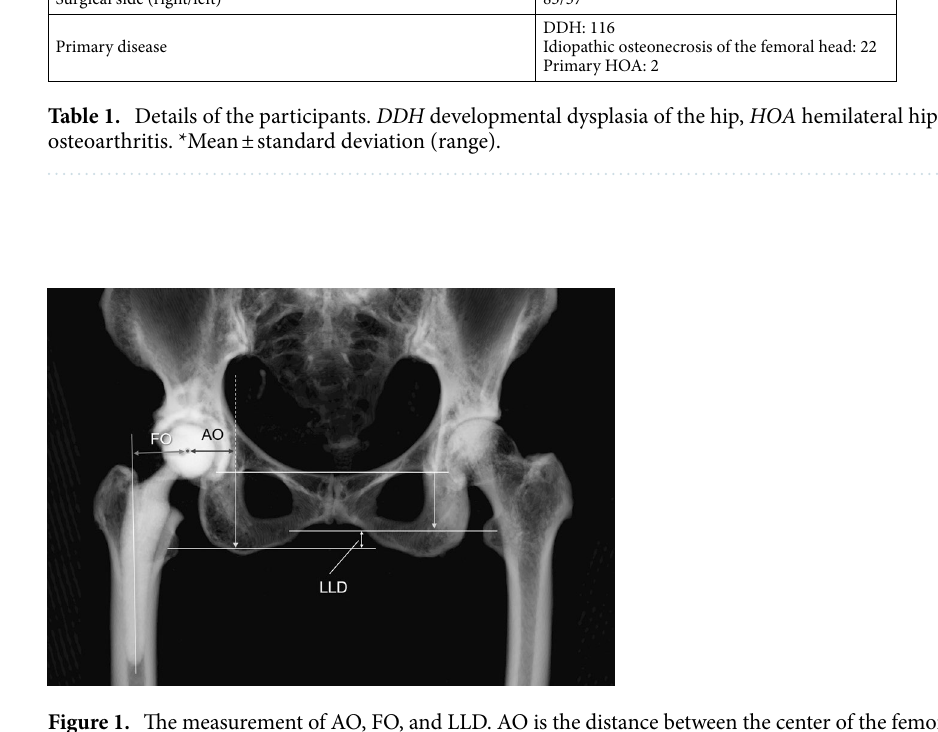
Figure 1. The measurement of AO, FO, and LLD. AO is the distance between the center of the femoral head and the medial wall of the teardrop. FO is the distance between the center of the femoral head and the anatomical axis of the femur. LLD is the difference between the surgical and nonsurgical sides. AO acetabular offset, FO femoral offset, LLD leg length